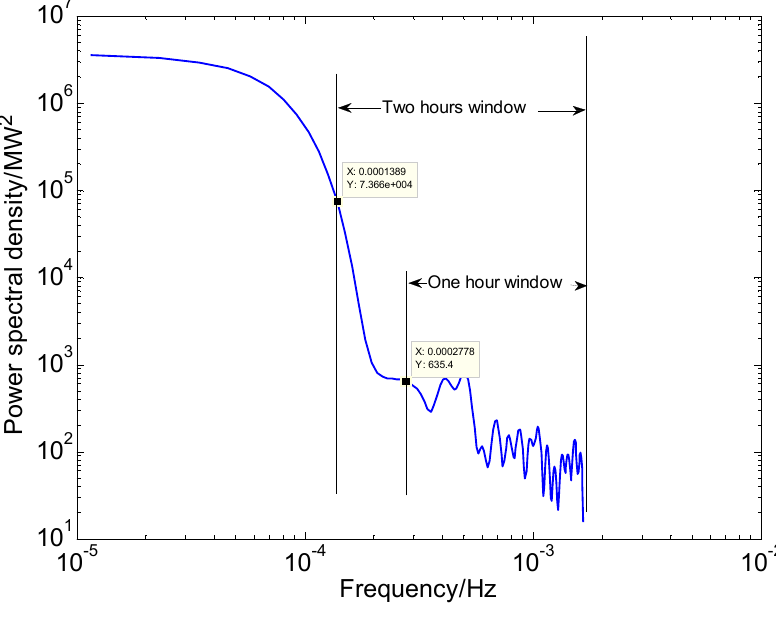
Figure 2. Wind power spectrum density